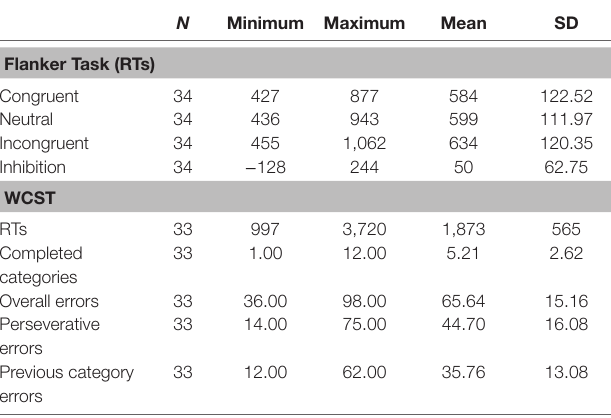
TABLE 2 | Descriptive data of cognitive control among participants.